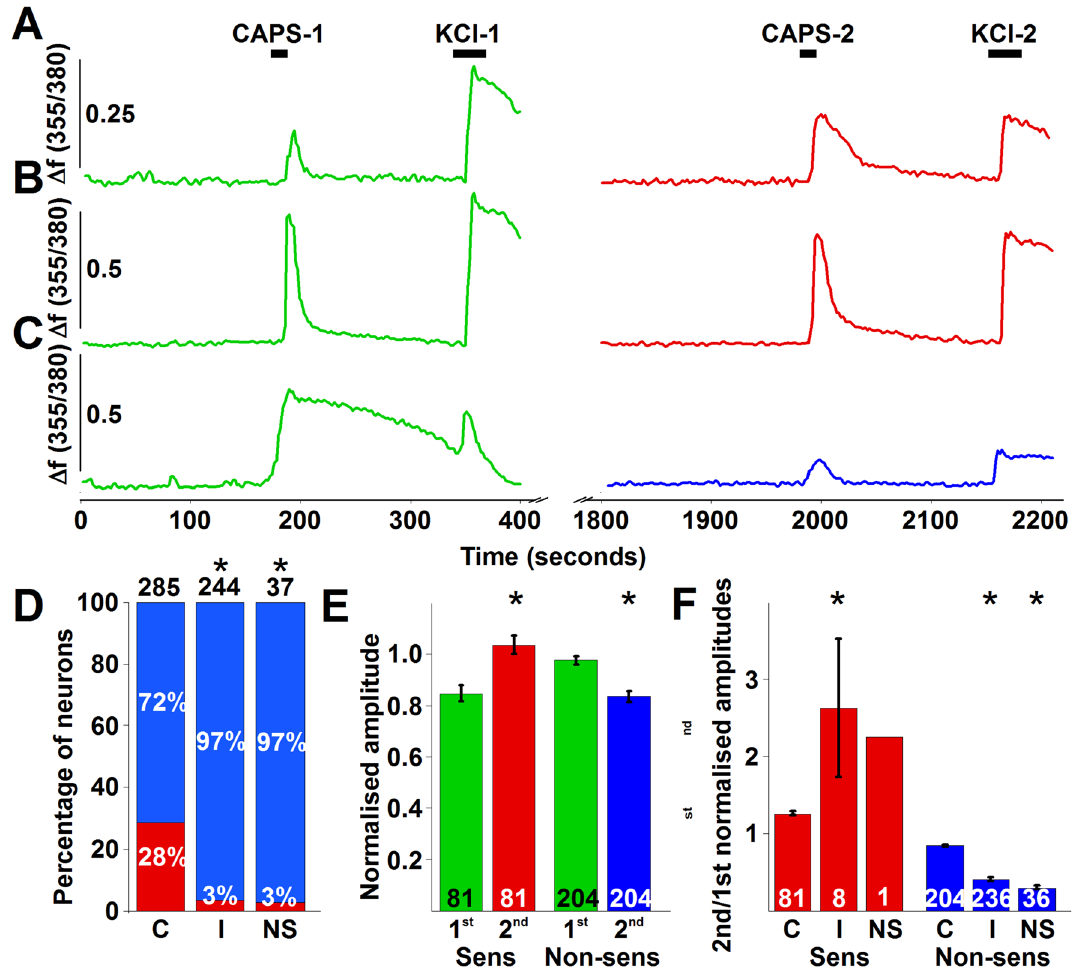
Figure 1. Capsaicin application to cultured murine primary sensory neurons induces sensitised responses to capsaicin applied 30 min after the first application in a group of neurons in a COX2-dependent manner. ( A – C ) shows typical recordings of changes in the intracellular Ca 2+ concentrations in three cultured murine primary sensory neurons in control extracellular buffer. Capsaicin (500 nM) was applied for 15 s at 3 (CAPS- 1) and 33 min (CAPS-2). Applications of capsaicin were followed by the applications of KCl (50 mM) 2 min after capsaicin applications (KCl-1 and KCl2). The neurons whose responses are shown in ( A , B ) exhibited absolute ( A ), or relative to the KCl-evoked response ( B ), sensitised second capsaicin-evoked responses when the amplitudes are assessed. The cell whose response is shown in ( C ) exhibited a non-sensitised response. ( D ) Relative number of neurons exhibiting sensitizer (red) or non-sensitizer (blue) phenotype in control extracellular buffer ( C ), and in the presence of indomethacin (10 μM; I) or NS-398 (3 μM; NS). Both indomethacin and NS-398 significantly reduced the proportion of sensitizers (p < 0.0001; Fischer’s exact test for indomethacin and p = 0.0002; Fischer’s exact test for NS-398). The numbers above the columns indicate the total number of capsaicin responding neurons. ( E ) Averaged normalised amplitudes (to the amplitudes of KCl-evoked responses) of first (green) and second (red for sensitizers (Sens), blue for non-sensitizers (Nonsens)) capsaicin application-evoked responses. In sensitizers and non-sensitizers the second capsaicin- evoked responses were, respectively, significantly greater (p < 0.0001; Student’s paired t-test; n = 81) and smaller (p < 0.0001, Student’s paired t-test; n = 204) than the amplitudes of the first capsaicin-evoked responses. The numbers at the bottom of the columns indicate the number of neurons. ( F ) Ratio of first and second normalised (to KCl-evoked responses) capsaicin-evoked responses in control buffer ( C ) and in the presence of indomethacin (10 μM; I) or NS398 (3 μM; NS) in sensitizer (Sens) and non-sensitizer (Non-sens) neurons. Both indomethacin and NS-398 increased or reduced the ratio in sensitizer or non-sensitizer neurons, respectively (indomethacin: p < 0.0001; Student’s t-test for sensitizers and p < 0.0001; ANOVA followed by Tukey’s post-hoc test for non-sensitizers; NS398: p < 0.0001; ANOVA followed by Tukey’s post-hoc test for non-sensitizers). The numbers at the bottom of the columns indicate the number of